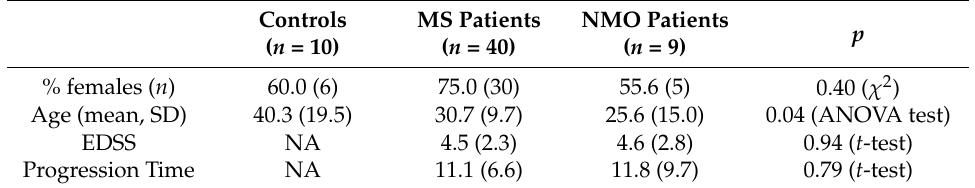
Table 2. General characteristics of series studied. SD: standard deviation; NA: not applicable; EDSS: expanded disability status scale.